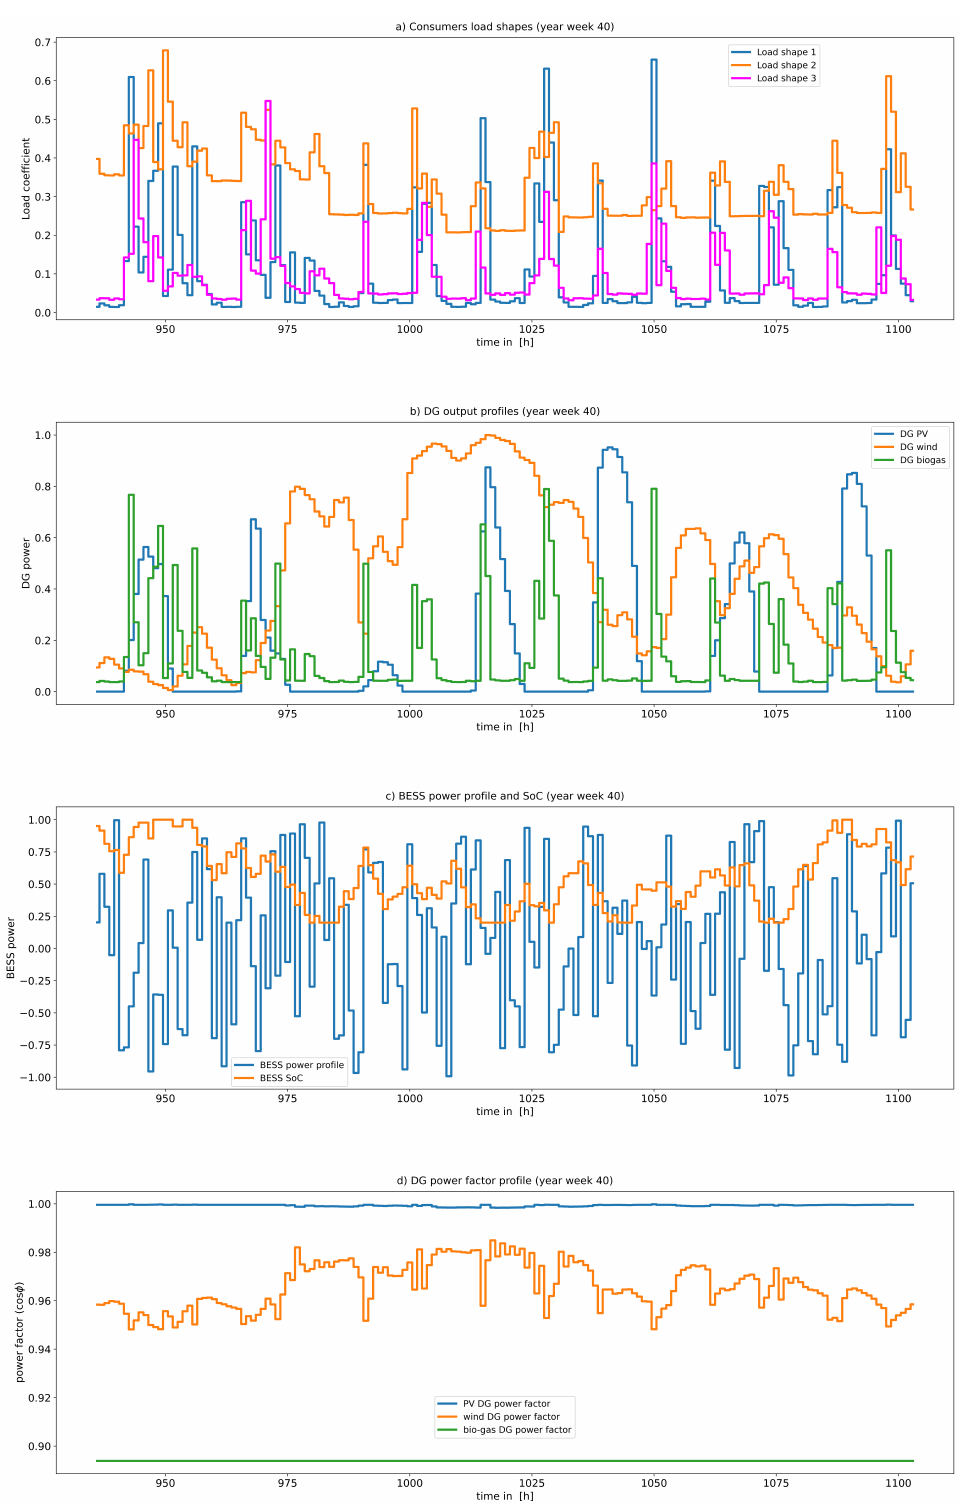
Figure 7. Load, DG and BESS profiles for 40th week in year: ( a ) Consumers load shapes, ( b ) DG output profiles, ( c ) BESS power profile and SoC, ( d ) DG power factor